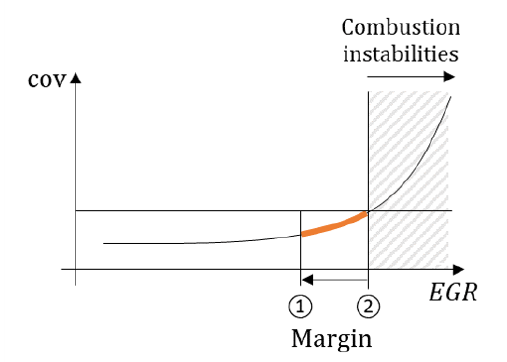
Figure 2. EGR calibration. 1 (cid:13) Calibration set point. 2 (cid:13) Optimal